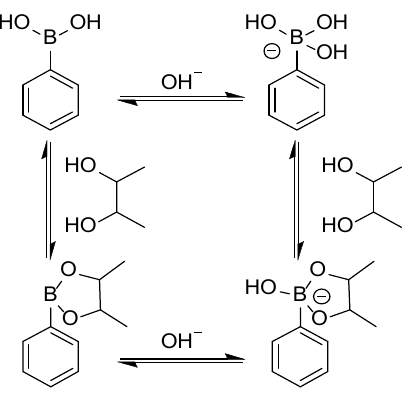
Figure 2. Binding equilibria of PBA to sugar and OH − ion.